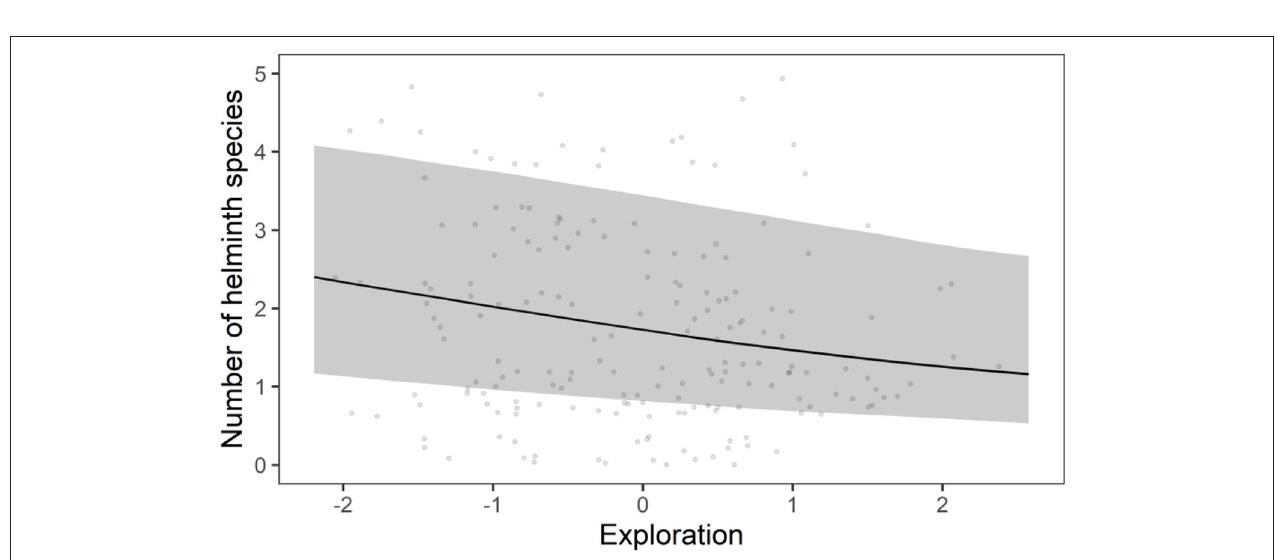
FIGURE 4 | Correlation between exploration and helminth species richness derived from the presence-absence model. The line represent the predicted correlation, while the shaded band represents the 95% credible interval. The points are the observed values per individual.